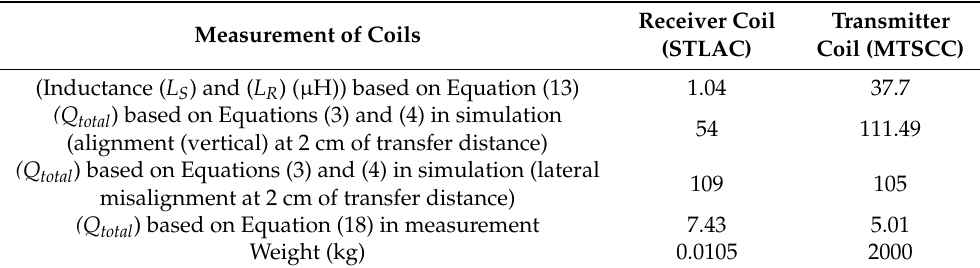
Table 4. The measurements and calculations of the transmitter and receiver